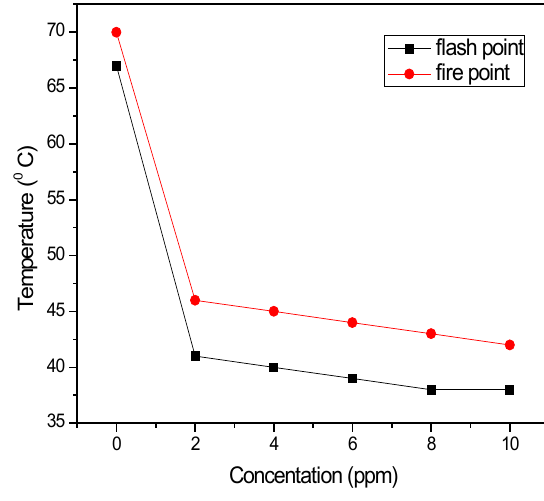
O Figure 7: Plot of fire and flash points as a function of concentration 3 4 of